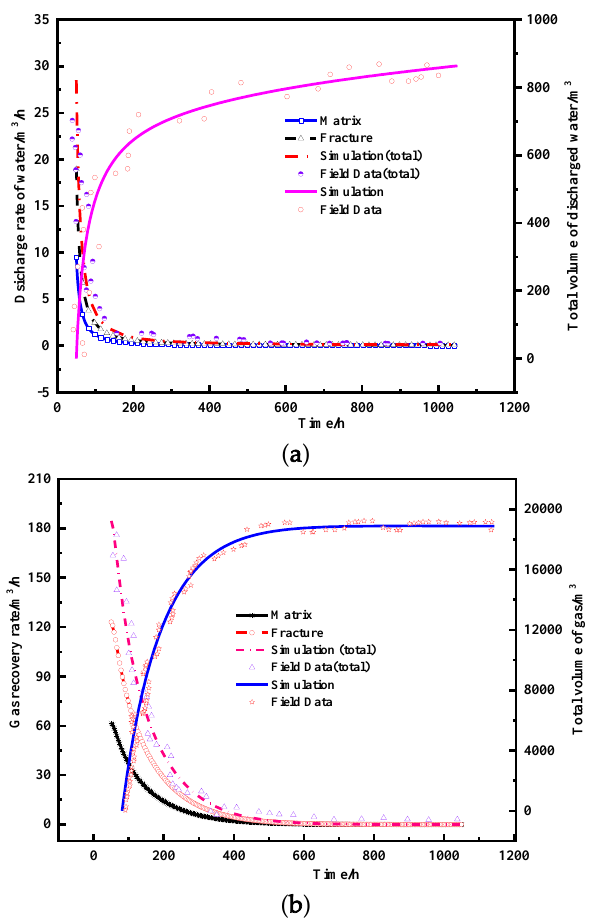
Figure 5. The location of long strike borehole.